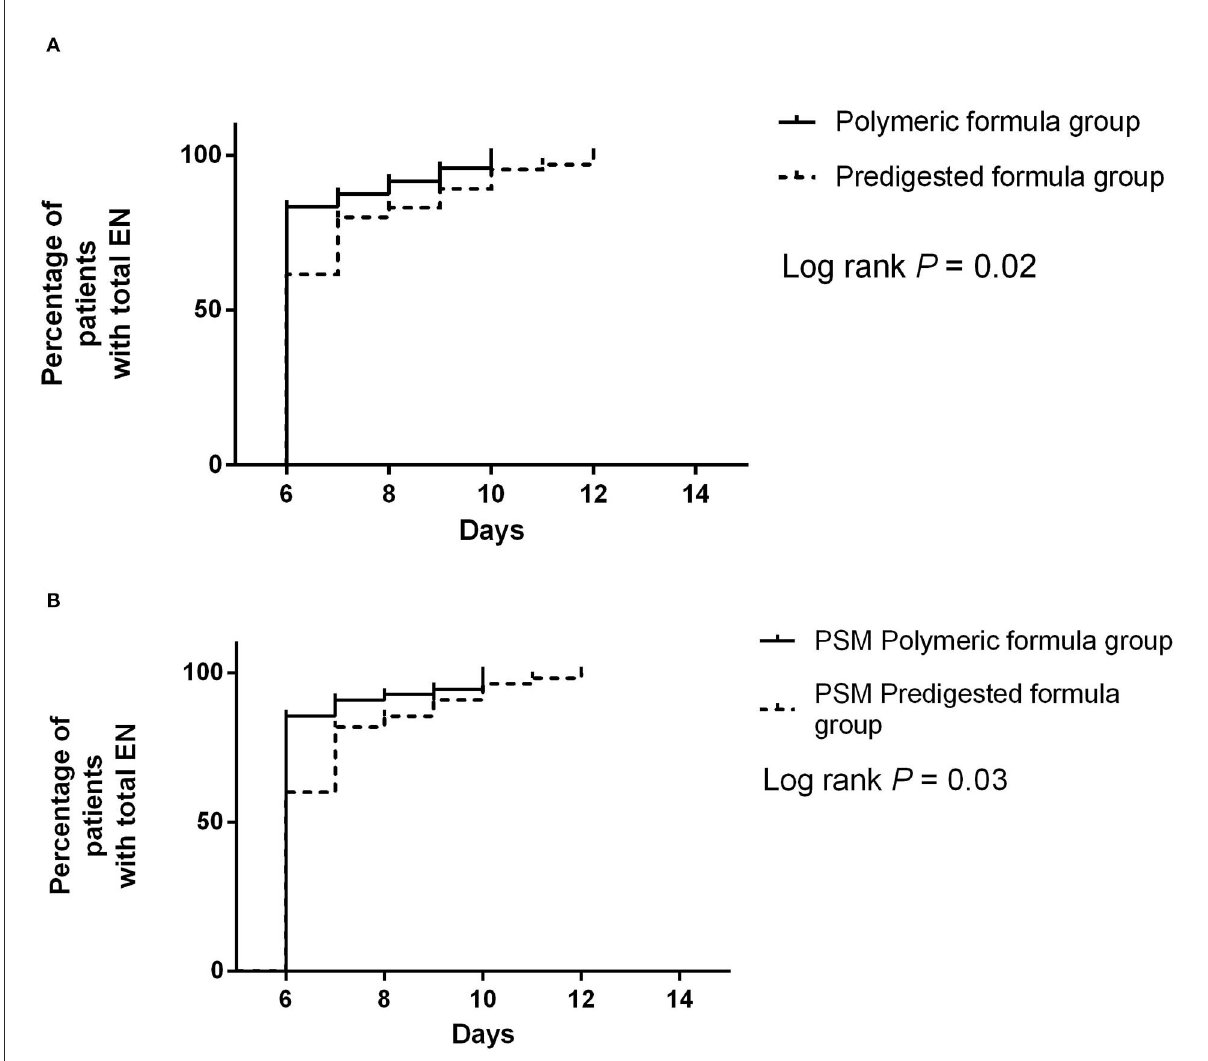
FIGURE5 (A) Difference of the resumption from minimal EN to total EN between the predigested formula group and polymeric formula group. (B) Difference of the resumption from minimal EN to total EN between the PSM predigested formula group and PSM polymeric formula